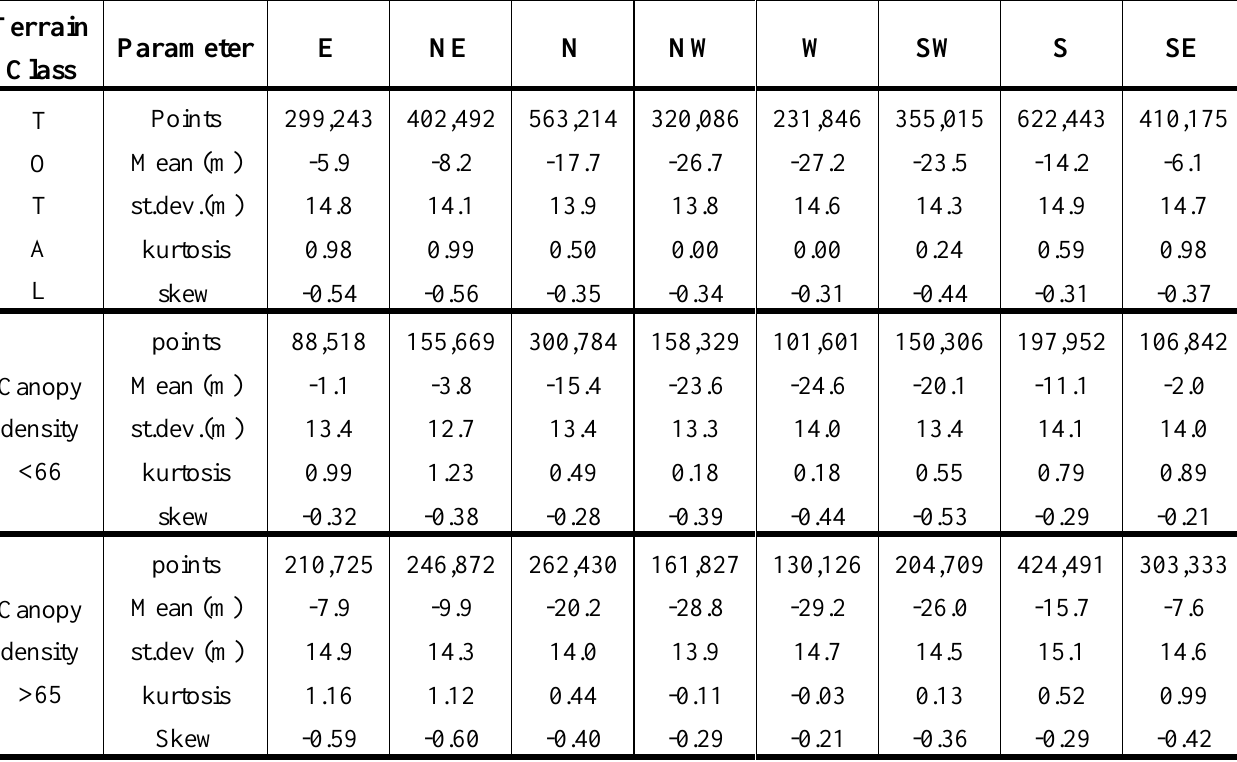
Table 1. Elevation difference statistics per geographic direction for the study area as well as for the 2 terrain subclasses formed by grid points with canopy density in [0,65] and [66,100] respectively.